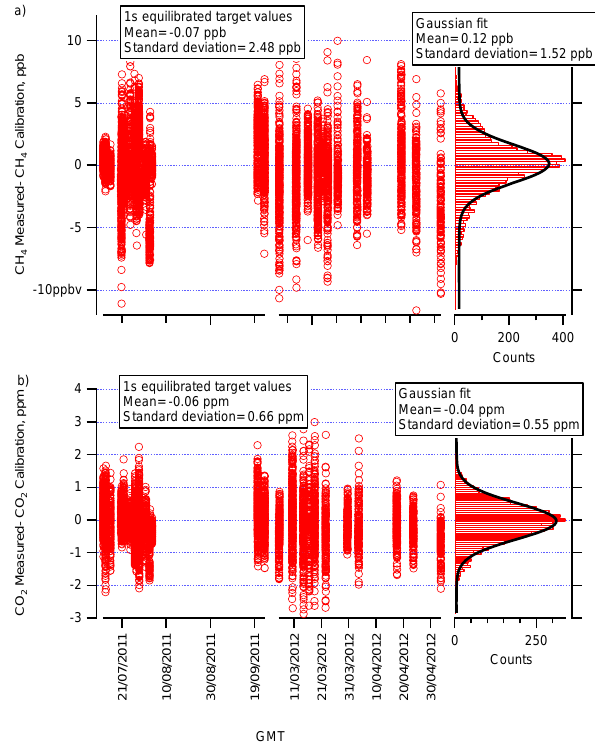
Fig. 6. An estimate of the system’s accuracy can be made by ex- amining the difference between the calibration mole fraction and the scaled FGGA measurement of the target gas mixture. At 1Hz the mean ± 1 standard deviation difference between the two is − 0.07 ± 2.48ppb for CH − 0.06 ± 0.66ppb for CO 4 and 2